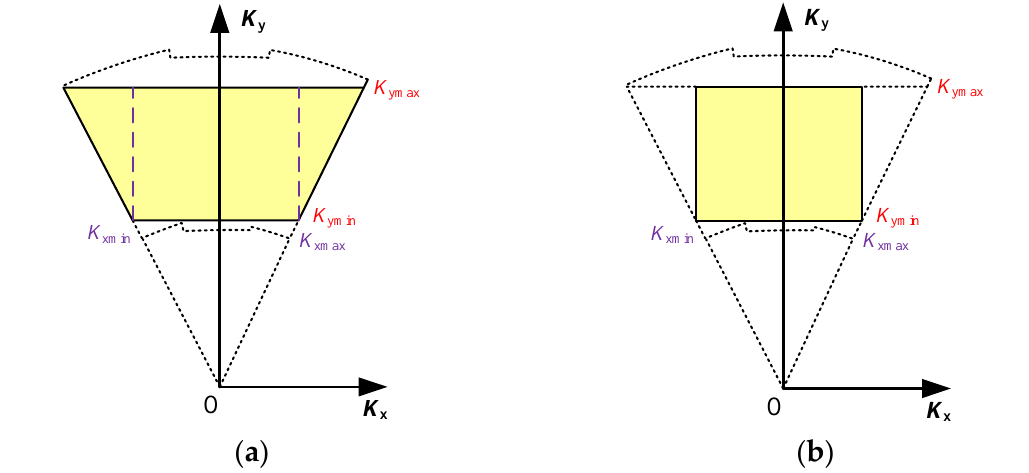
Figure 6. Wavenumber spectrum of the stitched data ( a ) after the range interpolation; and ( b ) after the azimuth interpolation.